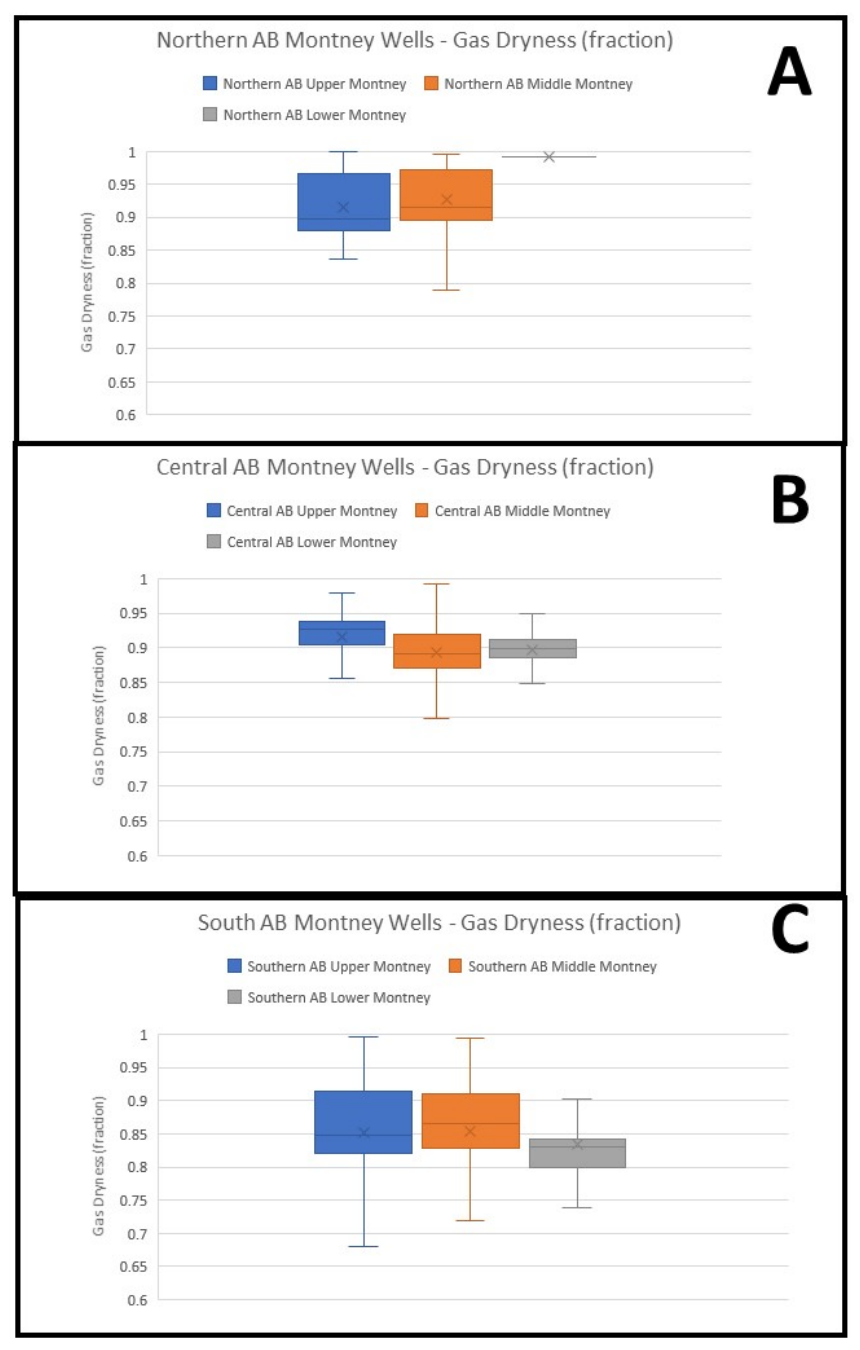
Figure 35. Box plot for the gas dryness ratio for the northern ( A ), central ( B ), and southern ( C ) regions of Alberta (AB). See Figure 2 for the location of these regions. There are no consistent trends between the Upper, Middle, and Lower Montney subunits when comparing the hydrocarbon composition. The Montney Formation becomes slightly drier in hydrocarbon composition from the Upper to Middle to Lower Montney subunits in northern AB. The Upper Montney is slightly drier than the Middle and Lower Montney subunits in Central AB. In the southern AB region, the gas composition is similar in the Upper and Middle Montney subunits with a wetter Lower Montney subunit. For northern AB Upper Montney wells, n = 172, with n = 54 for northern AB Middle Montney, n = 1 for northern AB Lower Montney, n = 323 for Central AB Upper Montney, n = 2229 for Central Middle Montney, n = 528 for Central AB Lower Montney, n = 1415 for southern AB Upper Montney, n = 363 for southern AB Middle Montney, and n = 57 for southern AB Lower Montney wells.